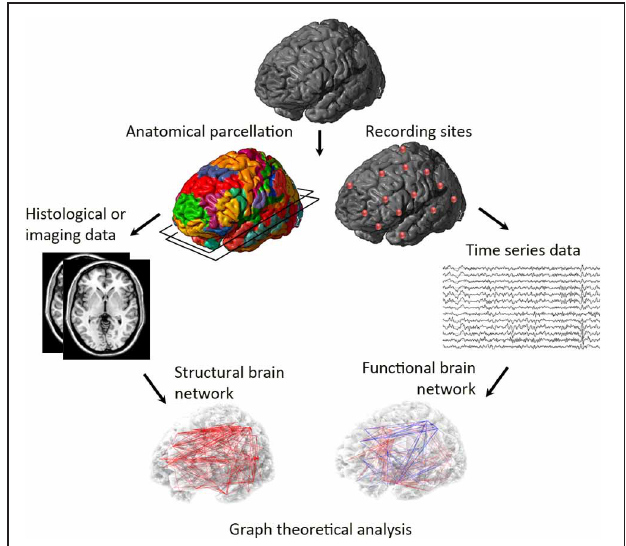
FIGURE 2 | Graph analysis to brain networks. Structural (including either gray or white matter measurements using histological or imaging data) or functional data (including resting-state fMRI, fMRI, EEG, or MEG data) is the starting point. Nodes are defined (e.g., anatomically defined regions of histological, MRI or diffusion tensor imaging data in structural networks or EEG electrodes or MEG sensors in functional networks) and an association between nodes is established (coherence, connection probability, or correlations in cortical thickness). The pairwise association between nodes is then computed, and usually thresholded to create a binary (adjacency) matrix. A brain network is then constructed from nodes (brain regions) and edges (pairwise associations that were larger than the chosen